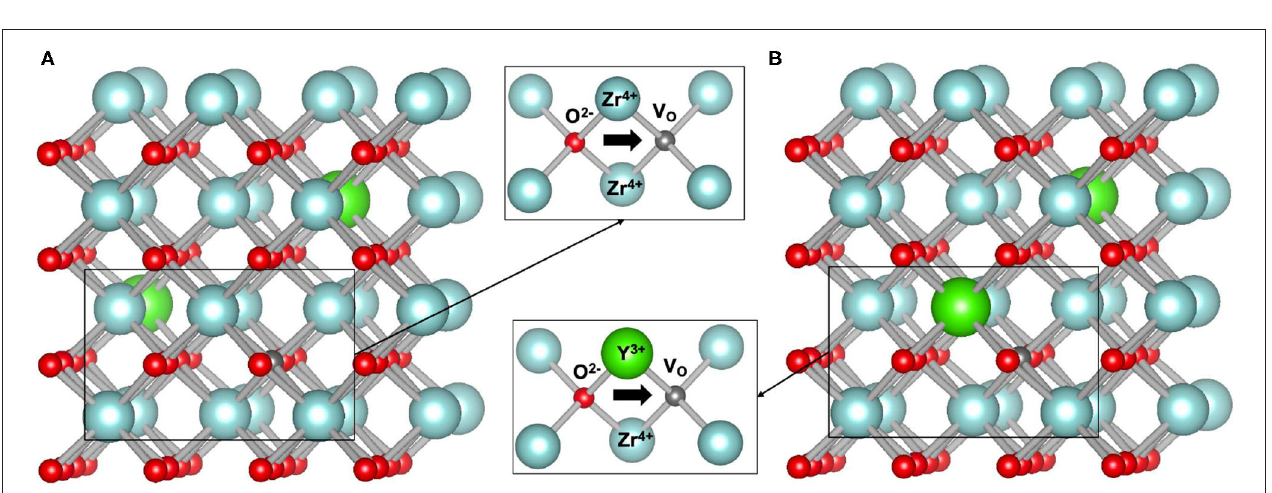
FIGURE 4 | The structure of yttria-stabilized zirconia (YO 1.5 − ZrO 2 system) with indication of the oxygen diffusion mechanism along possible Zr-Zr (A) and Y-Zr (B)